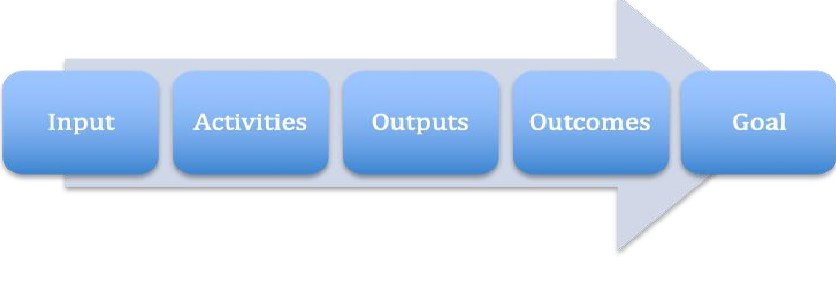
Figure 3: Impact value chain illustration; Source: Adopted from the Goldman Sachs Foundation,